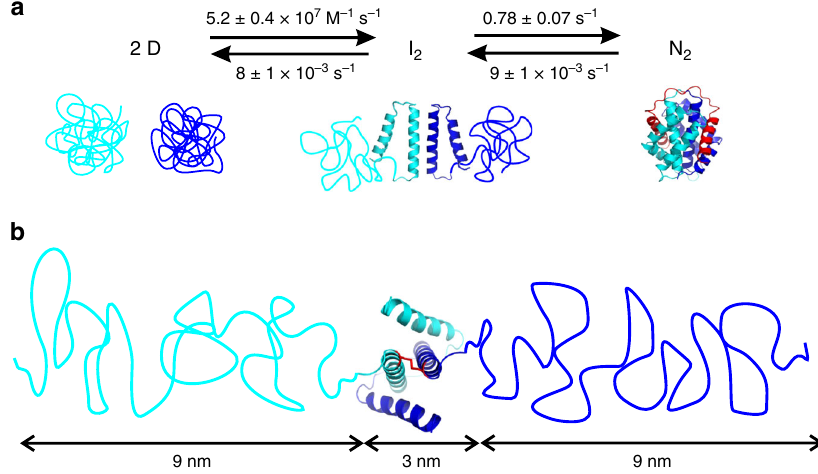
Fig. 5 Reaction scheme of CTD self-assembly and structural model of the intermediate. a Reaction scheme, rate constants and structural model of two-step folding and dimerization of the CTD. The two subunits constituting the dimer are colored blue and cyan. Unstructured coils and helices are depicted in cartoon representation. C-terminal helix 5 in N 2 , which swaps domain and threads through the chain of the opposing subunit, is highlighted red. b Structural model of the dimeric intermediate I 2 . Chain dimensions of unfolded helices 1 – 3 inferred from FRET spectroscopy and polymer theory, and of the dimer core formed by helices 4 and 5, are indicated. The disul fi de that covalently connects the N-terminal ends of helices 4 is highlighted in red stick